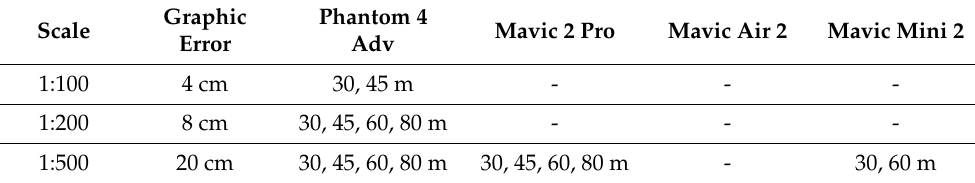
Table 14. Altimetric graphic errors when performing flights at different AGLs.